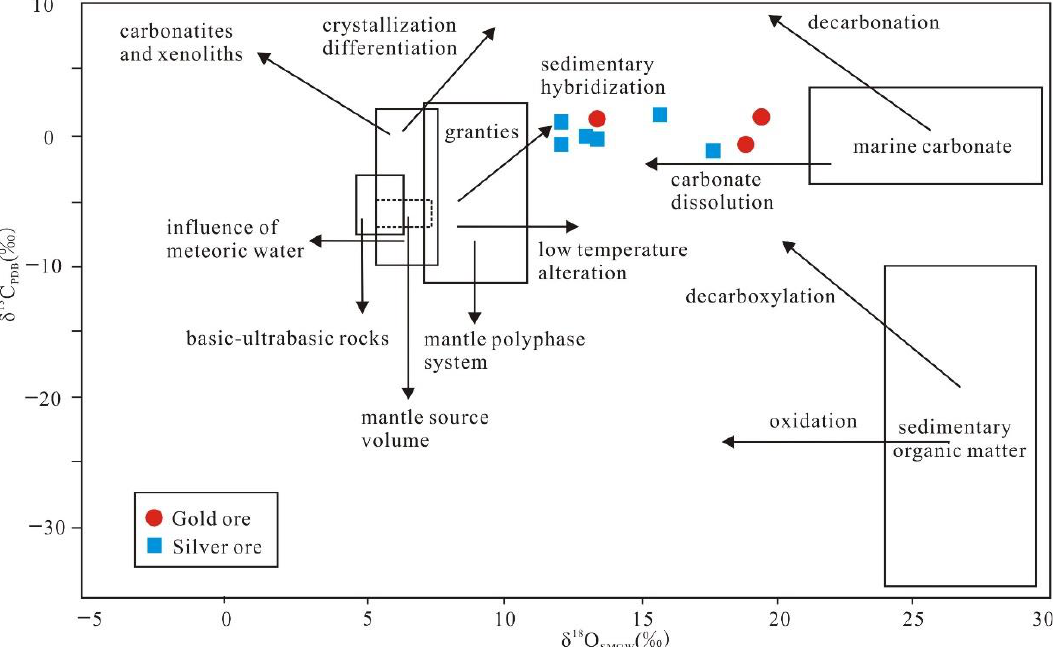
Figure 14. Plot of δ 13 C PDB vs. δ 18 O SMOW for the Changkeng – Fuwan Au-Ag deposit (from [92] ).